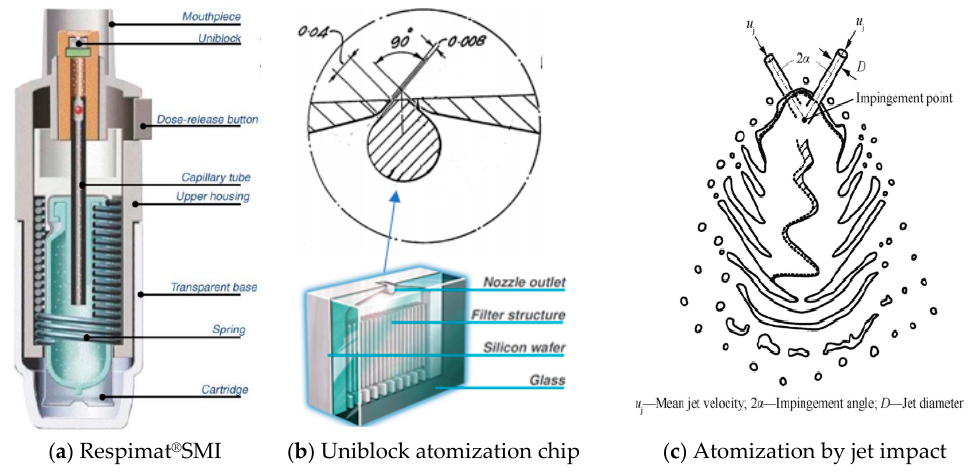
Figure 1. Components of Respimat ® SMI Inhaler and mechanism of atomization